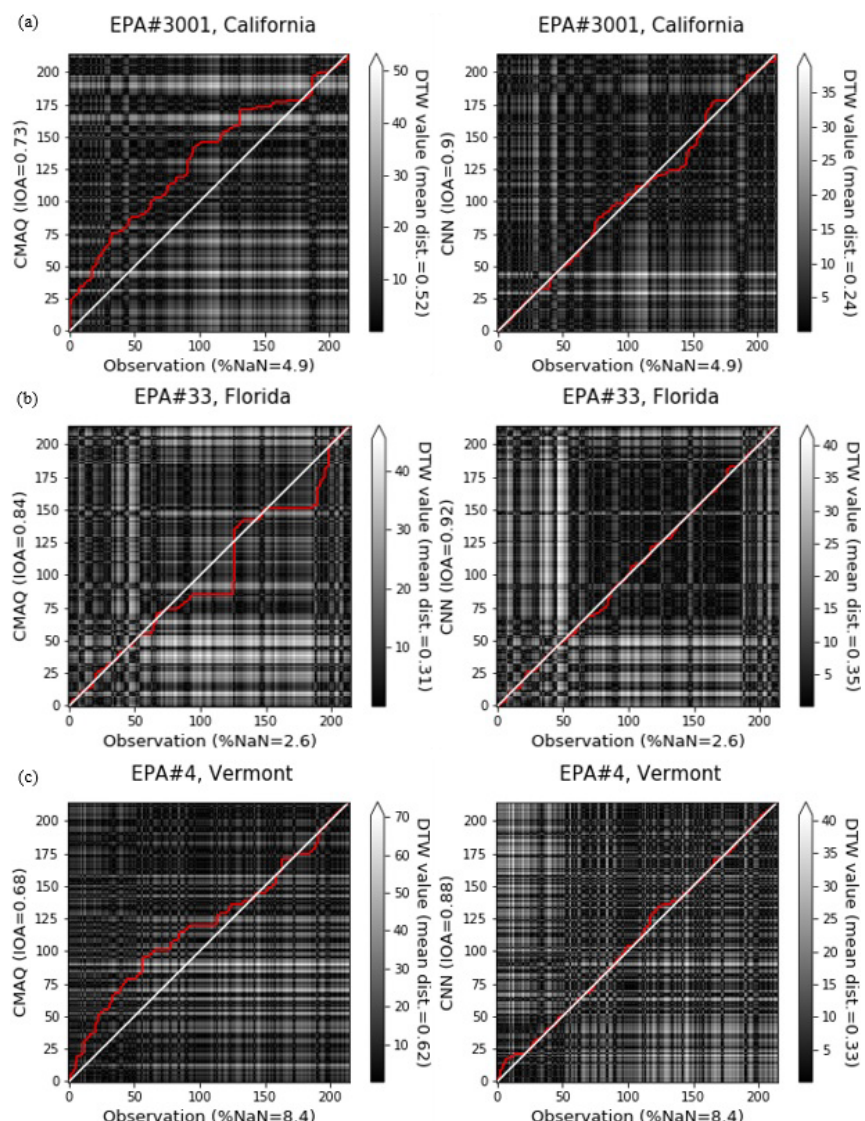
Figure 7. Comparison of the distance analysis of CMAQ and CMAQ-CNN predictions for EPA stations (a) no. 3001 (California), (b) no. 33 (Florida), and (c) no. 4